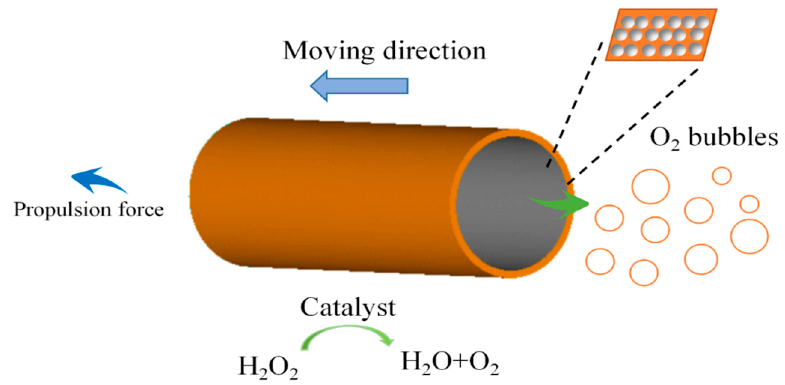
Figure 3. The motion of a nanojet could be promoted significantly by embedding nanoengines with Pt nanoparticles, which is called particle-assisted rolling . The technique fulfills this task by increasing the reaction activity from the dispersed catalytic nanoparticles. The technique is helpful for the motor locomotion with low-concentrations of fuel.